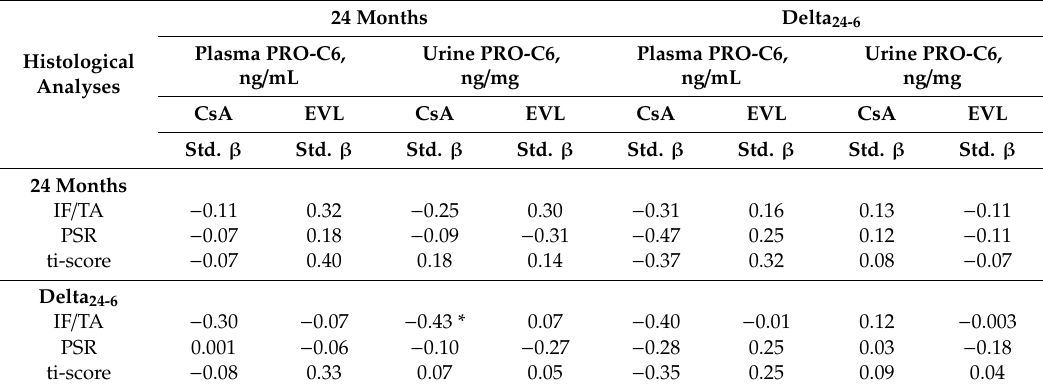
Table 5. Association of histological analyses with plasma and urine PRO-C6 among CsA and EVL